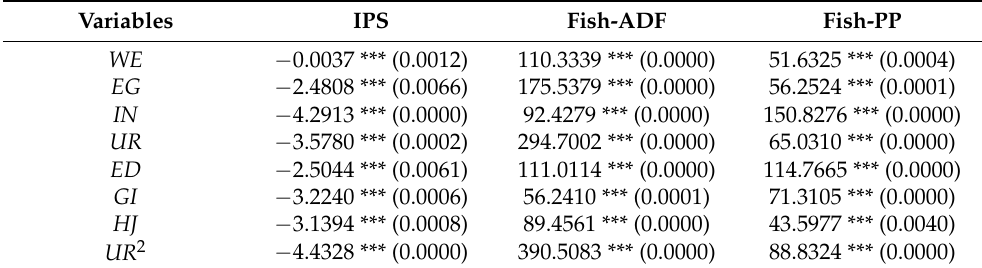
Table 7. Results of first-order unit root test.